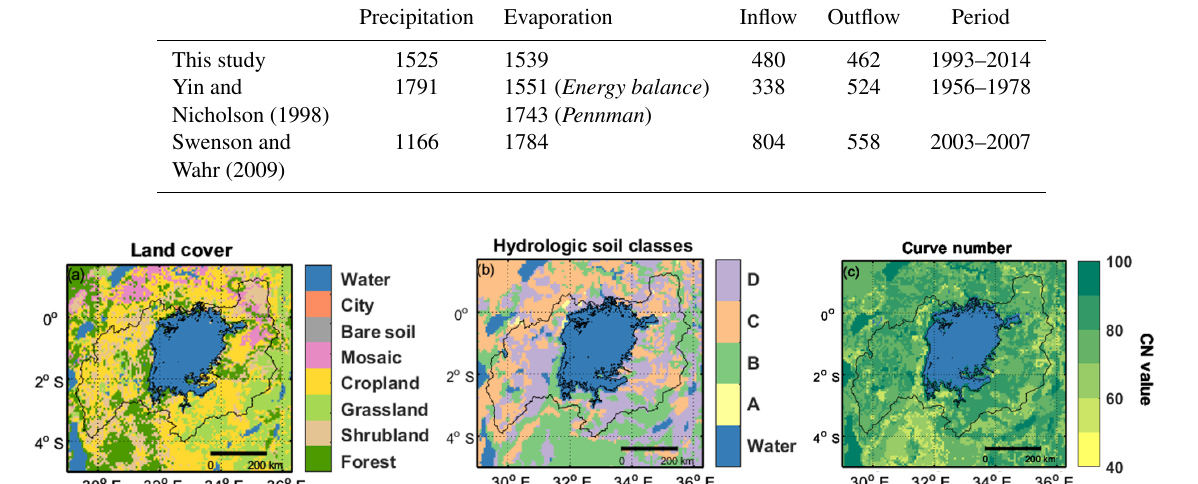
and with the Pennman method (1743 mm yr − 1 ). By